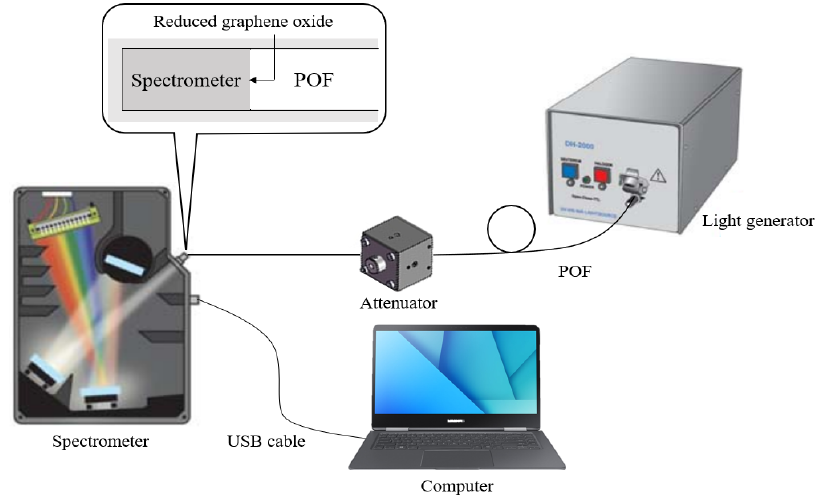
Figure 1. Experimental setup for measuring transmitted light intensities through RGO membranes on a POF using a light generator.